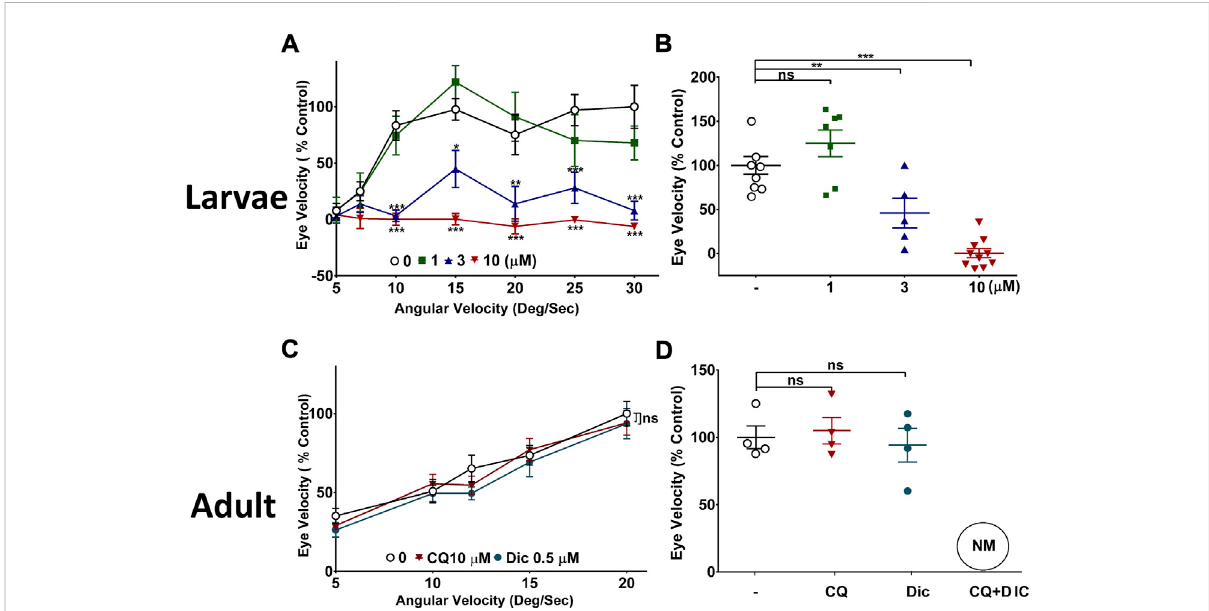
Effect of clioquinol on visual function of zebra fi sh. (A,B) CQ impairs visual function in zebra fi sh larvae. Three dpf PET strain zebra fi sh were exposed to up to 10 μ M CQ for 48 hfollowed by optokineticresponse (OKR) measurementat fi ve dpf at (A) varying angular velocitiesof stimulus (B) atone angular velocity of stimulus (15 deg/sec). The visual function was measured intermsof eye velocity underbi-directional motion stimulus. The average velocities of both right and left eyes were used to compare the effect of CQ and is represented as % control. The graph shows the average eyevelocityofzebra fi shlarvae ofatypicalexperiment. (C,D) Effect ofCQon visualfunction inadult zebra fi sh. Adultzebra fi sh wereexposed to10 μ MCQ,0.5 μ MDicorDMSOfor48 hunder14:10light:darkcycleconditionsbeforevisualacuitywasmeasured.Thevisualacuitywasassessed bymeasuringeyevelocityatvaryingangularvelocities (C) andatoneangularvelocity(15deg/sec) (D) withaunidirectionalstimulus.Onlytheaverage velocityofrighteyewasusedtocomparetheeffectsofCQ.Datarepresentstheaverageeyevelocitytheadultzebra fi shofatypicalexperiment. P *